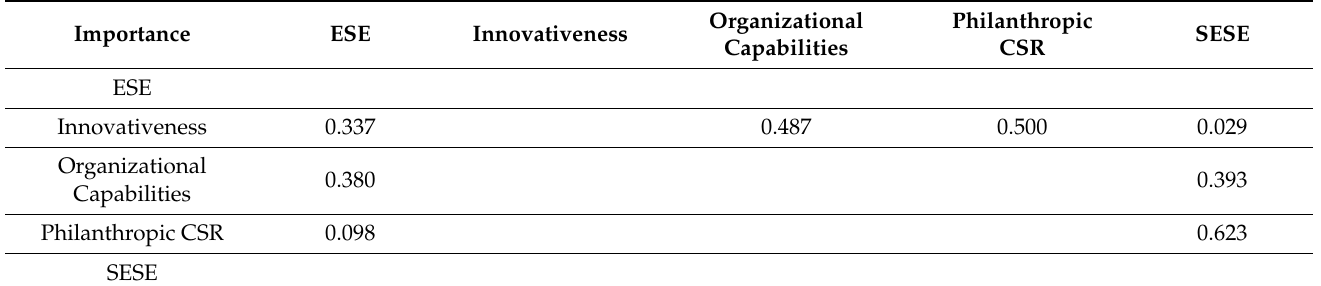
Table 5. Importance of innovativeness in the